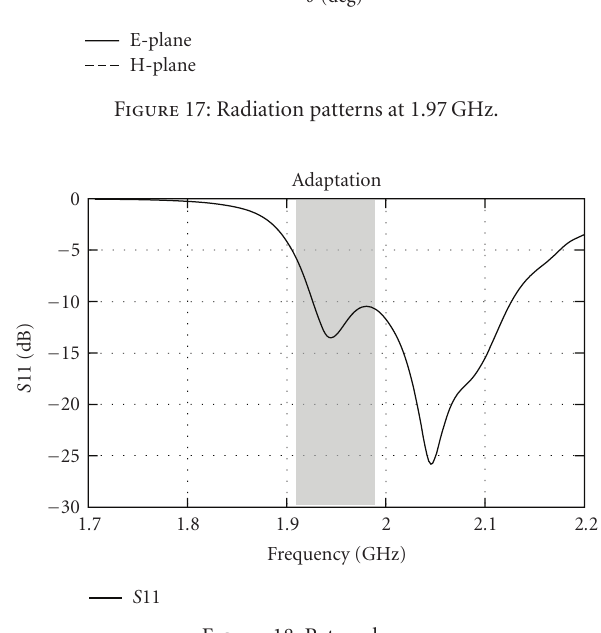
Figure 18: Return